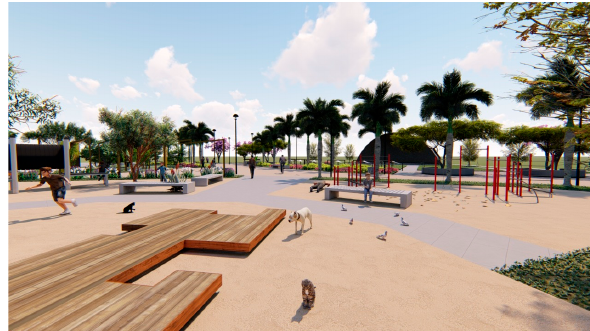
Figure 15. Fitness space and rest areas.